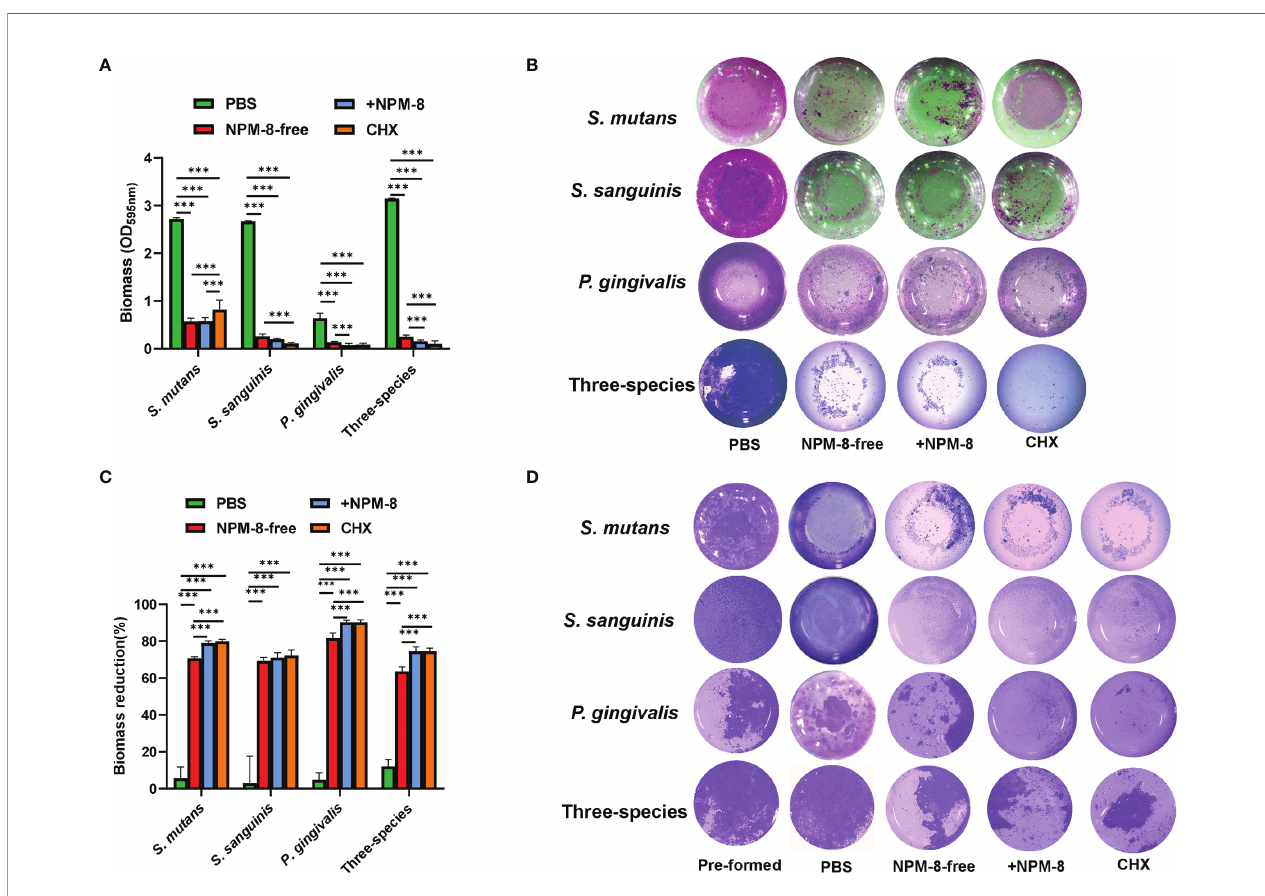
FIGURE 3 | Antibio fi lm activity of the four test agents on S. mutans , S. sanguinis and P. gingivalis single-species and three-species bio fi lms. (A) Quantitative analysis of the effect of test agents on the bio fi lm formation. (B) Representative crystal violet staining images of the bio fi lms. (C) Quantitative analysis of bio fi lm biomass reduction. (D) Representative crystal violet staining images of the pre-formed bio fi lms and the bio fi lms after treatment. Data are presented as means ± SD. *** P <